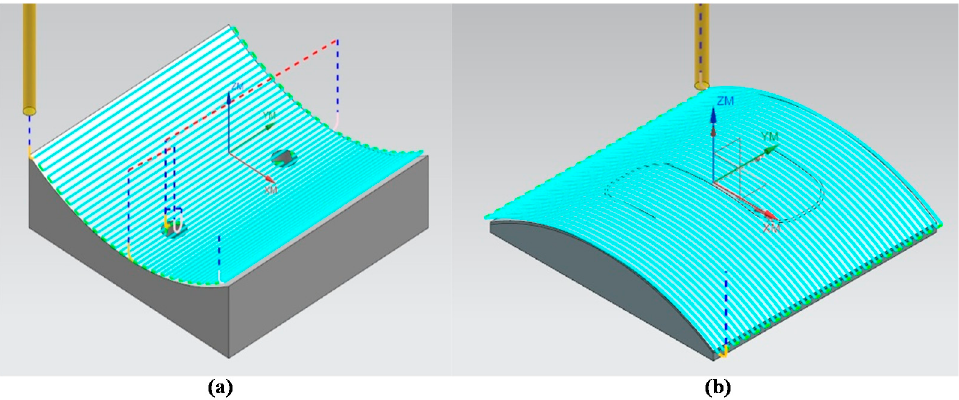
Figure 3. ( a ) Blue lines indicate planned cutting path for top cover substrate; ( b ) blue lines indicate planned cutting path for bottom